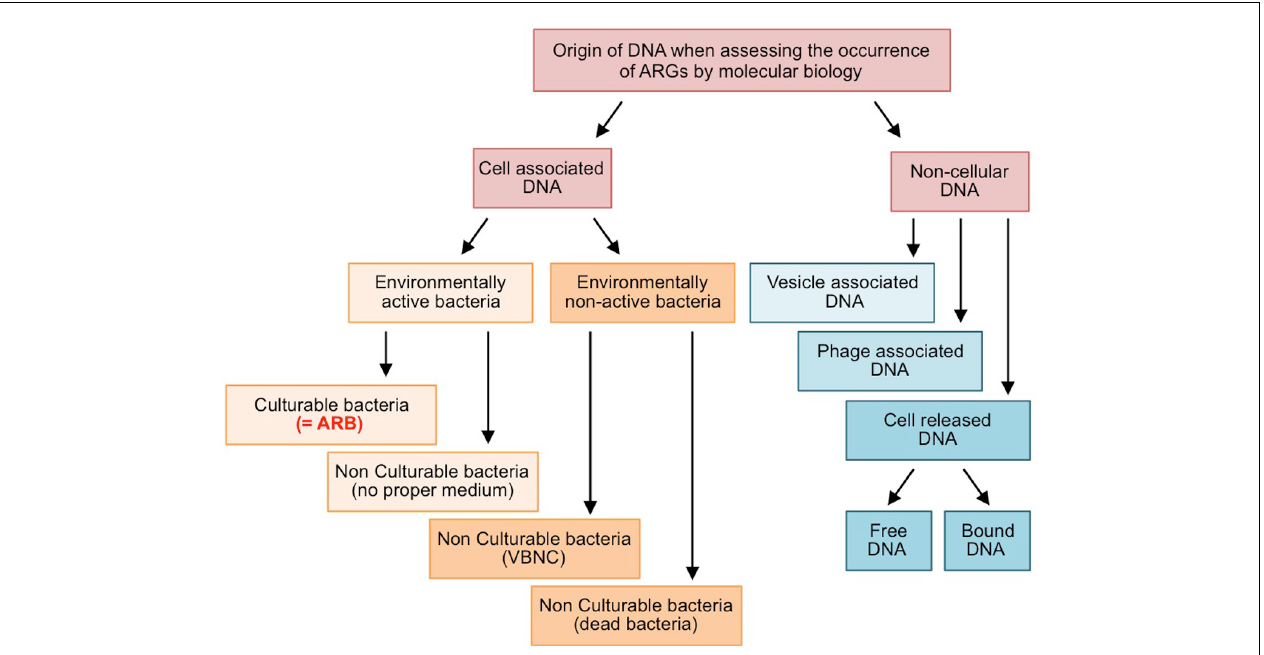
FIGURE 1 | Forms and origins of ARGs quantified by molecular biology approaches. VBNC: viable but non-culturable